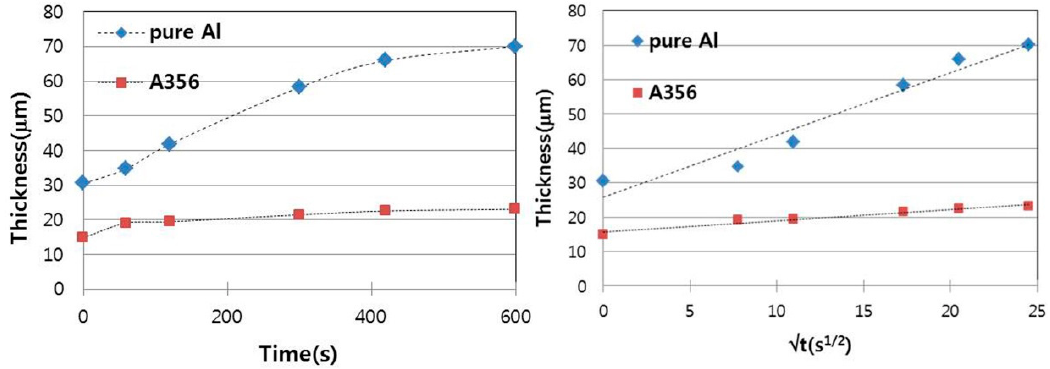
Figure 7. Thickness changes of compounds formed at the cast iron/liquid Al (pure) and at the cast iron/Al–Si alloy (A356) interface with heating time at 720 °C.